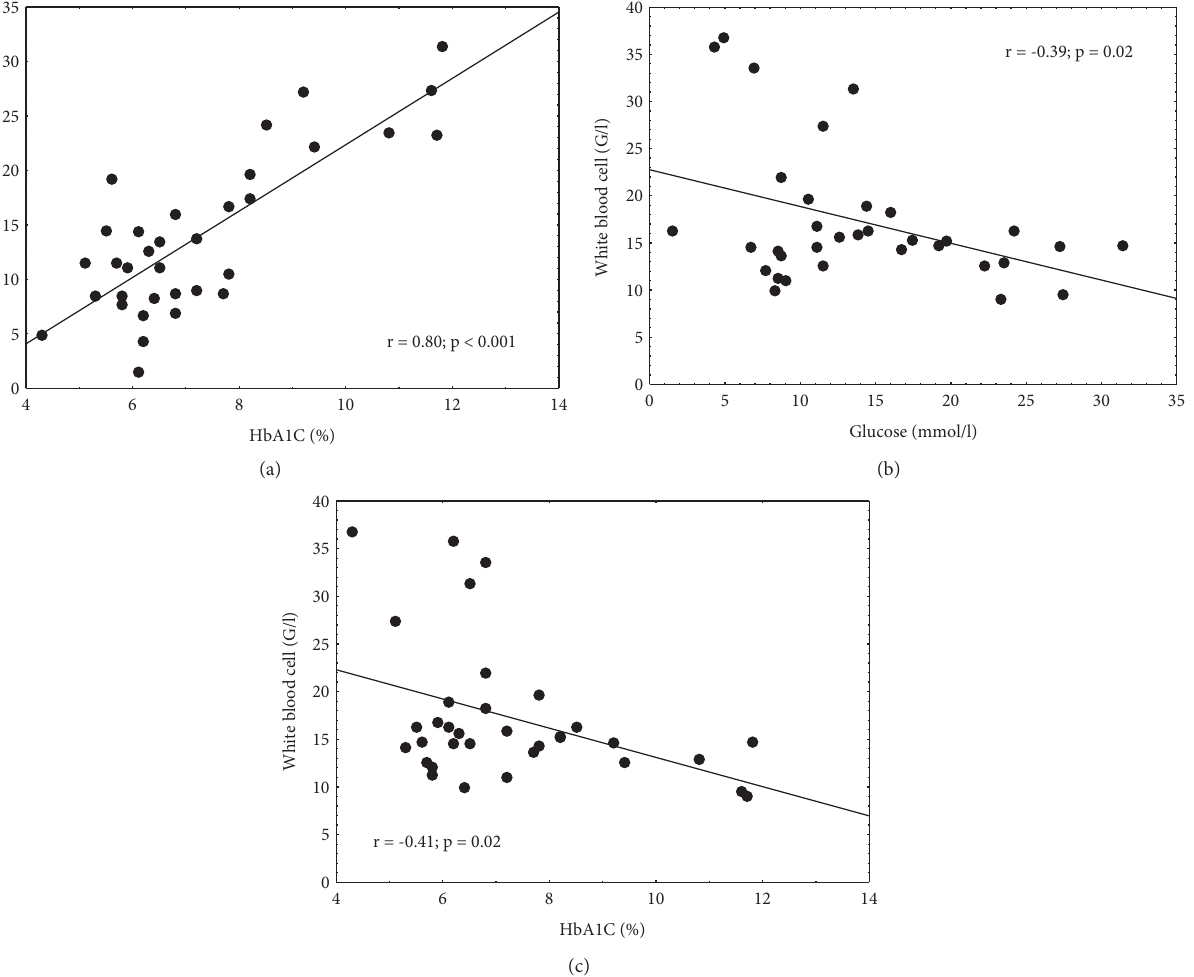
Figure 3: Correlations between glucose and HbA1C (%). (a) Glucose and white blood cell count. (b) White blood cell and HbA1C (%) in diabetic, SOFA 24h septic patients ( n �